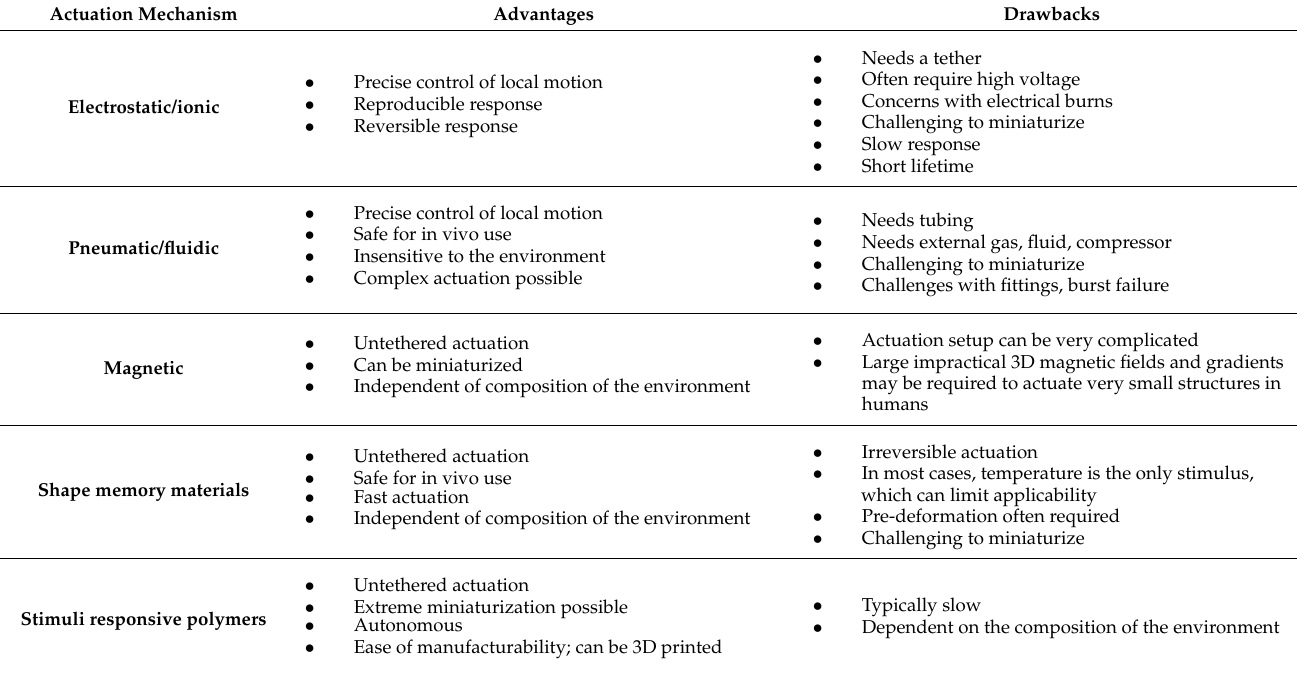
Table 1. Comparison of Common Actuation Mechanisms for Microgripping Technology. Reprinted with Permission from Ref. [4]. Copyright